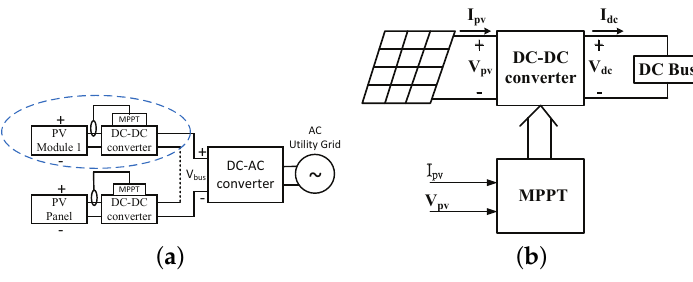
Figure 9. PV system setup ( a ) DMPPT topology, ( b ) Enlarged version of a single DMPPT system.